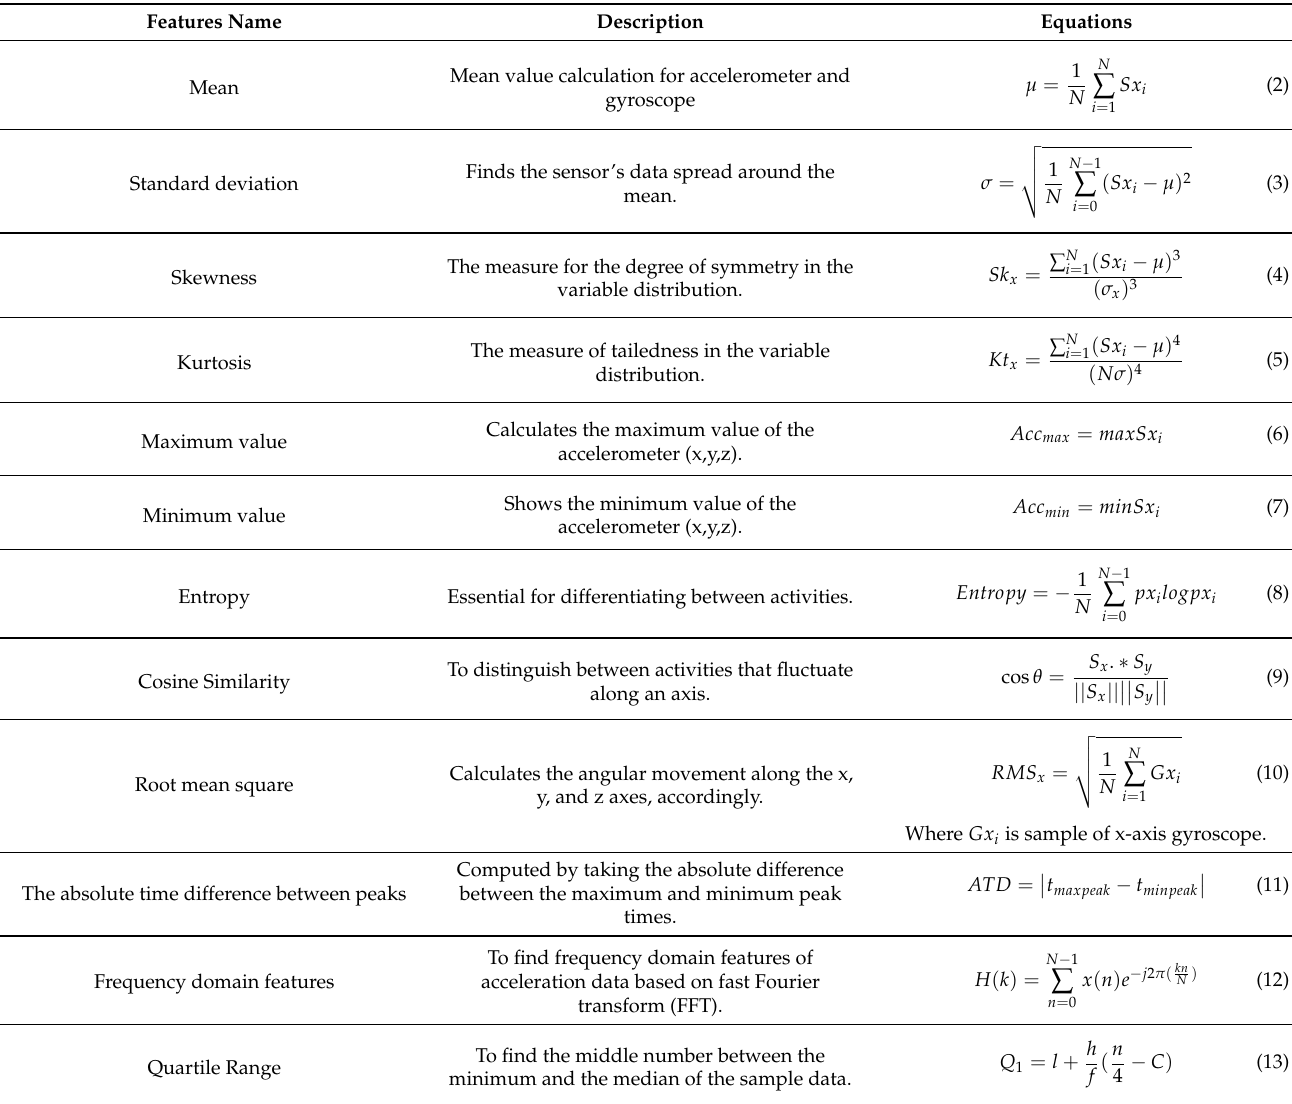
Table 4. Feature extraction from time-series data of multiple